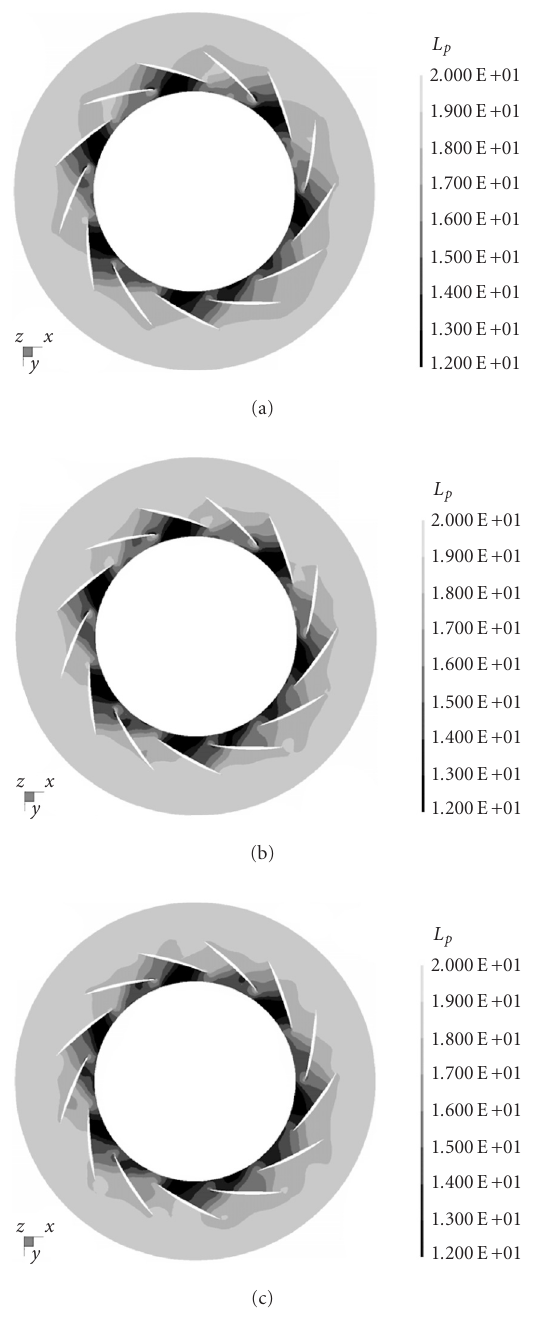
Figure 18: Static pressure on the di ff user center plane for the vaned case at near-surge conditions: (a) starting position, (b) 1 / 3 revolu- tion, and (c) 2 / 3 revolution.